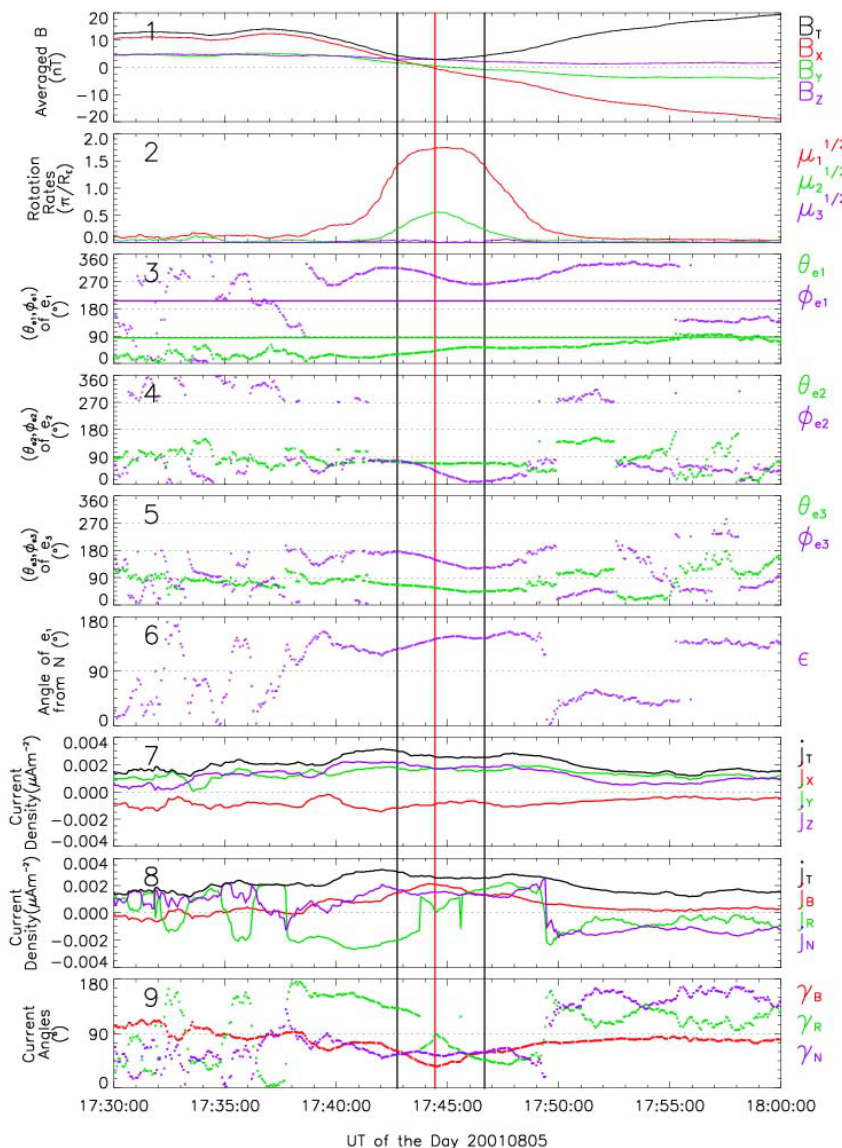
Fig. 1b. The geometric structure of the tilted current sheet during one Cluster crossing event on 5 August 2001. Panel 1: the magnetic field at the center of Cluster tetrahedron as are the average of those at the four spacecraft; panel 2: the maximum, medium and minimum rotation rate of the magnetic field; panel 3: the directional angles ( θ e 1 , ϕ e 1 ) of the first eigenvector ˆ e ( 1 ) ; panel 4: the directional angles ( θ e 2 , ϕ e 2 ) of the second eigenvector ˆ e ( 2 ) ; panel 5: the directional angles ( θ e 3 , ϕ e 3 ) of the third eigenvector ˆ e ( 3 ) ; panel 6: the angle ε between the first eigenvector ˆ e ( 1 ) and the binormal of the MFLs; panel 7: The three components ( j x , j y , j z ) of the current density at GSM coordinates; panel 8: The three components ( j B , j R , j N ) of the current density at the local natural coordinates, where j B is the field-aligned component, j R the component along the curvature and j N along the binormal; panel 9: the angle ( γ B , γ R , γ N ) between current density and magnetic field, curvature and binormal of the MFLs, respectively. GSM coordinates are used here. The polar angle and azimuthal angle of the position vector of Cluster in GSM are also plotted in the two panels of ∇ B/B direction and ˆ e ( 1 ) direction as green and violet horizontal lines,